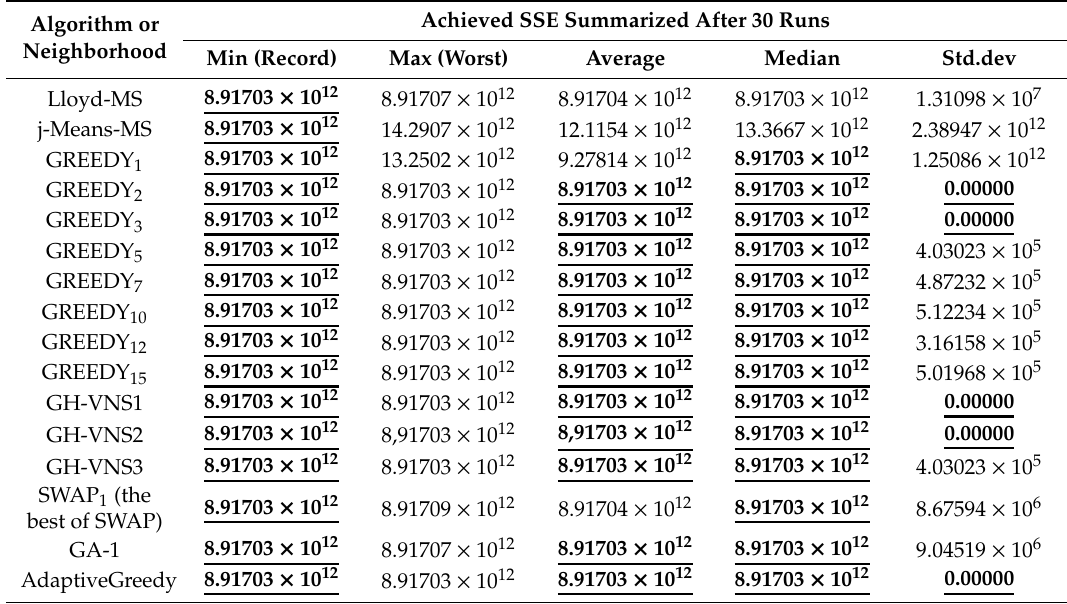
Table A8. Comparative results for S1 data set. 5000 data vectors in R 2 , k = 15 clusters, time limitation 1 s. Algorithm